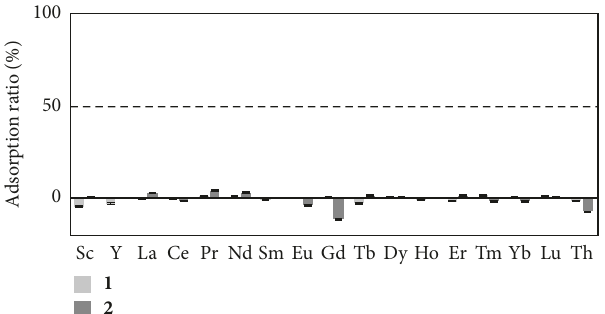
Figure 3: Metal adsorption from multielement solution B with hydrophilic sulfur-containing adsorbents 1 and 2 (feed molar ratio of [C S]/[total metal] (cid:31) (cid:31)